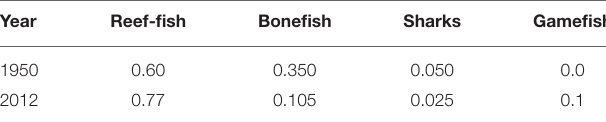
TABLE 4 | Fish allocation (fractions) for 1950 and 2012 for both subsistence and artisanal catches, interpolated for years